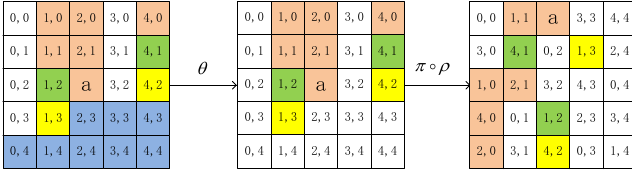
Figure 21: Attack on 6-round Ketje Sr v1 with 128-bit Nonce